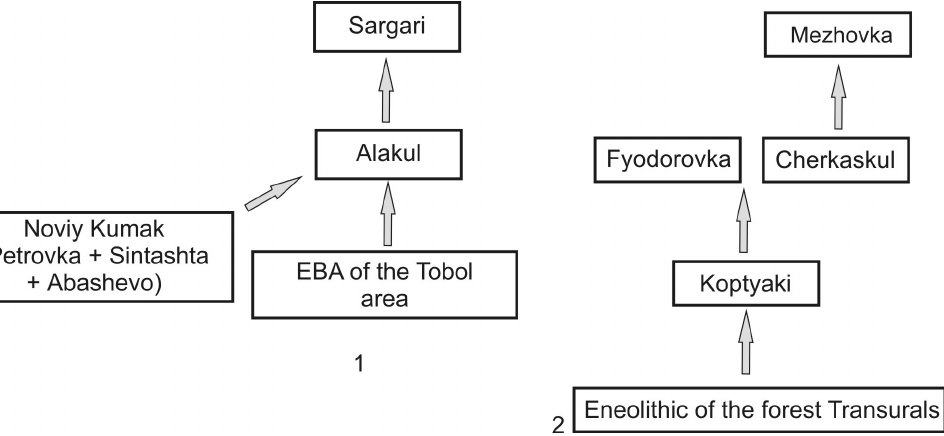
Figure 12. Scheme of Alakul culture genesis of T.M. Potemkina (1983, 1985, 1994) (1) and Fyodorovka-Cherkaskul cultural genesis of M.F. Kosarev (1981)